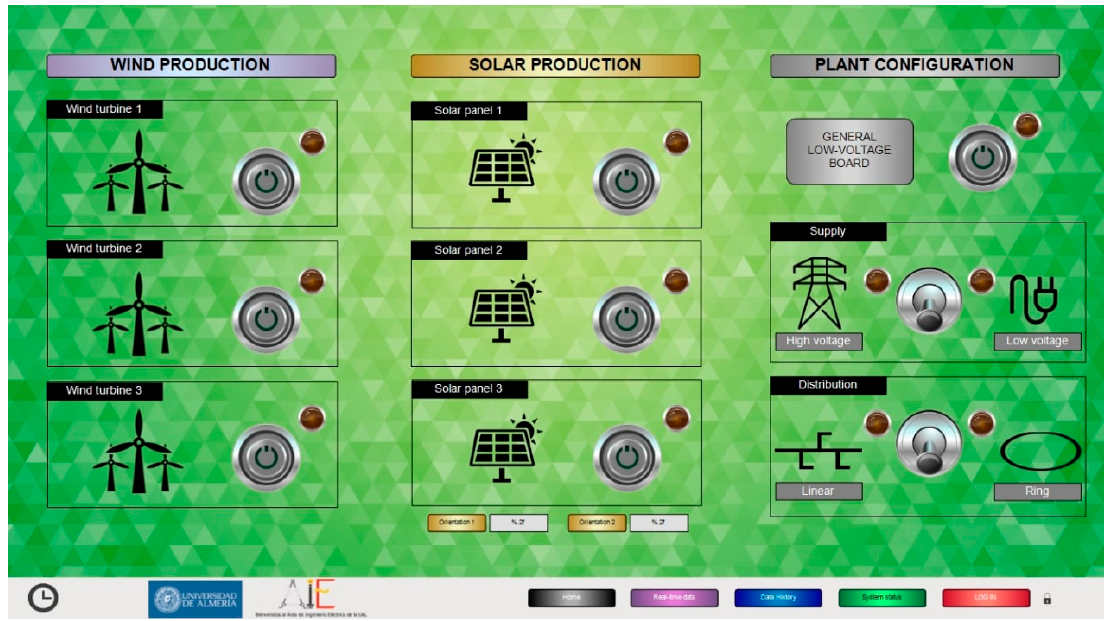
Figure 10. System status